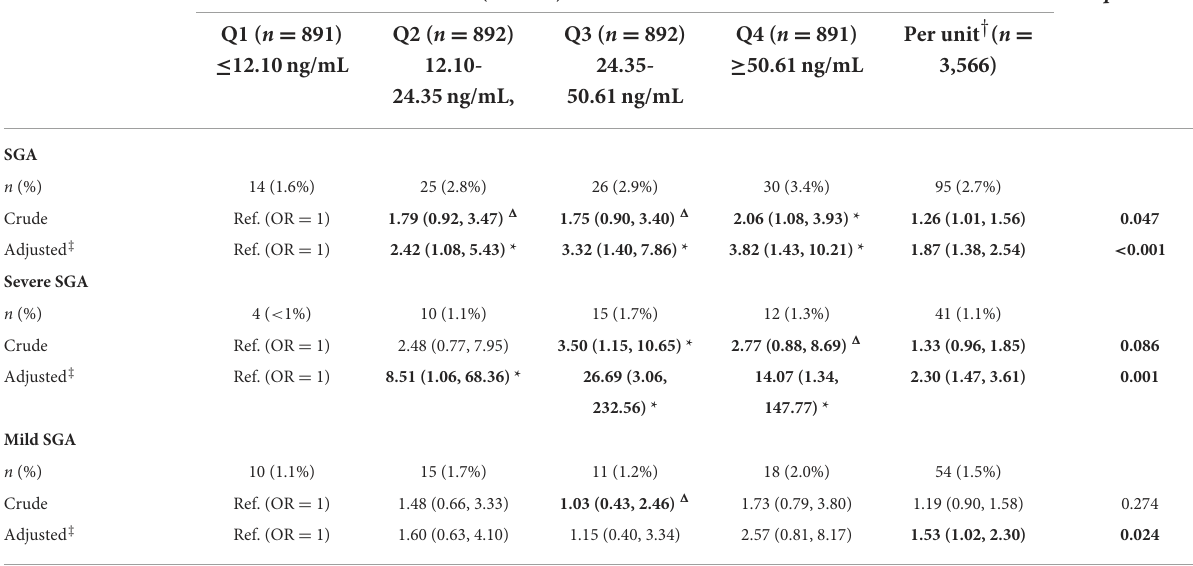
TABLE 3 Risk of small for gestational age and subcategories associated with maternal ferritin